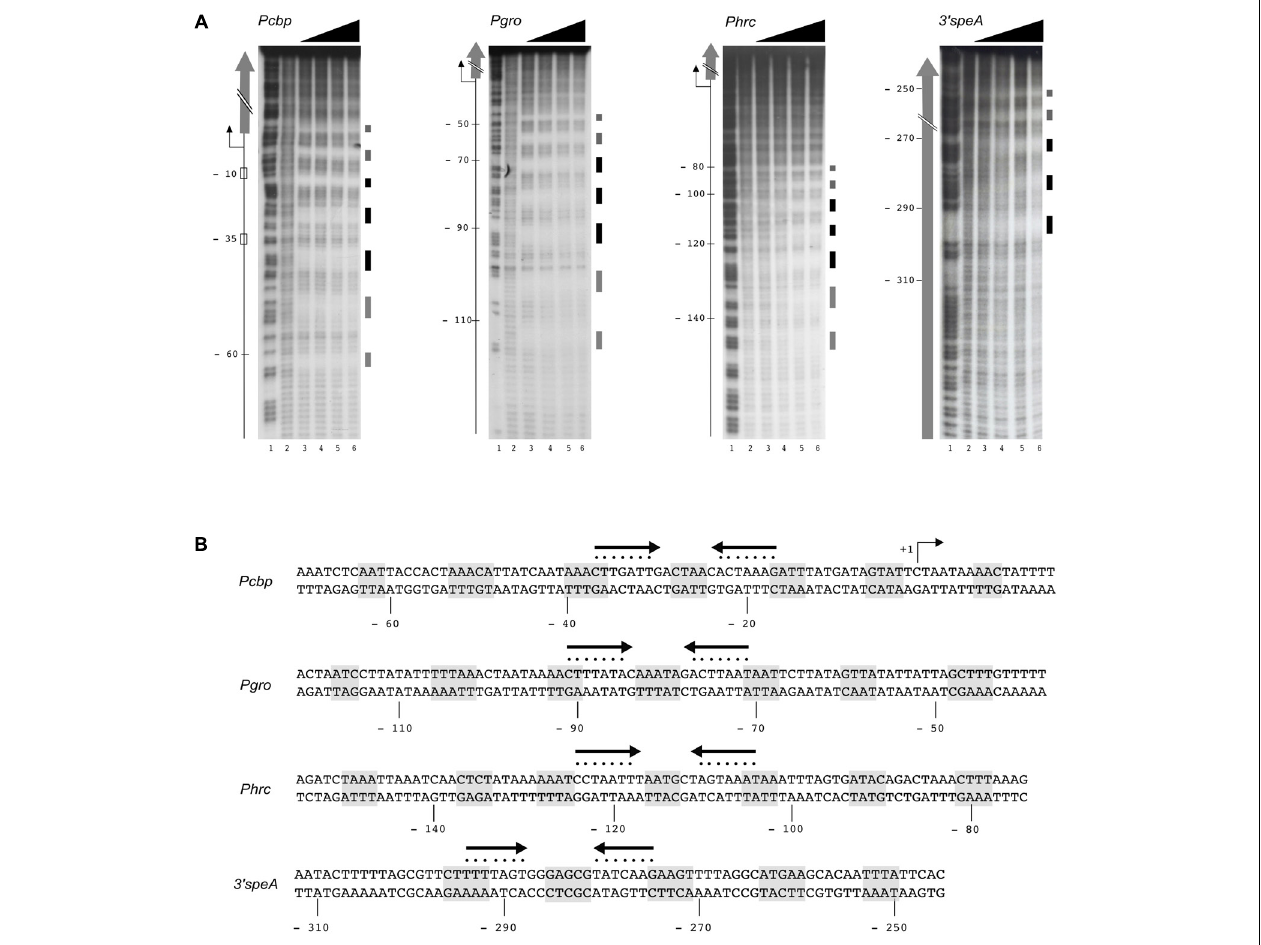
FIGURE 3 | HspR binds extended DNA regions. (A) Hydroxyl-radical footprint experiments on HspR positive target genes identified by ChIP-seq analysis. From left to right, specific DNA probes for P cbp , P gro , P hrc , and speA fragments were radioactively end-labeled on the coding strands, and incubated with increasing amounts of purified HspR protein prior hydroxyl-radical digestion. P cbp , P gro , P hrc labeled probes were mixed with 0; 47.5; 95; 190; 380 nM HspR (lanes 2–6); while speA probe was mixed with 0; 60.7; 121.5; 243; 486 nM HspR (lanes 2–6). Purified DNA fragments were separated on a polyacrylamide denaturing gel along with a G + A sequence reaction ladder as reference marker (lane 1 in all the panels). On the right of each panel, black and gray boxes represent strong and weak HspR protected regions, respectively. On the left, the –10 and –35 regions and the transcriptional start site (+1, bent arrow) are indicated and the open reading frames are depicted with vertical gray arrows. The relative position of the HspR binding site on the promoter regions of P cbp , P gro , P hrc is reported with respect to the transcriptional start site, while those mapped on the coding sequence of speA gene are reported with respect to the translational stop codon. (B) Nucleotide sequences of HspR binding sites on the promoter regions of the three heat-shock operons (P cbp , P gro , P hrc ) and on the 3 (cid:48) coding region of the speA gene. The HspR protected regions identified in (A) are shaded in gray, while the inverted repeat sequences similar to the HAIR consensus motif are depicted as converging black arrows and each nucleotide of the motif is marked with a dot. Nucleotide positions with respect to the transcription initiation sites are reported on the non-coding